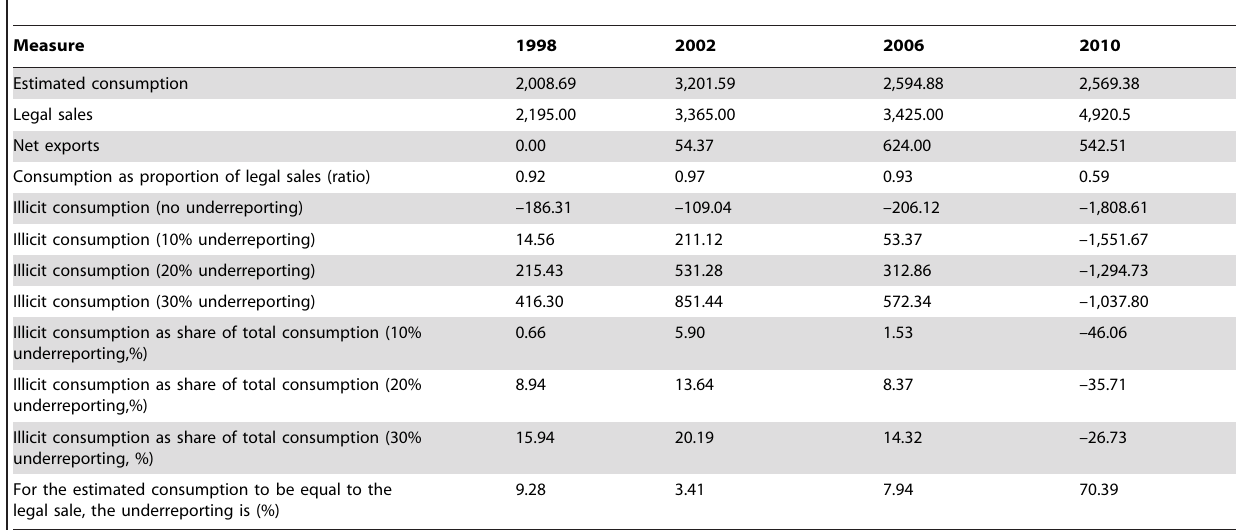
Table 2. Legal Cigarette Sales, Estimated Consumption, and Illicit Consumption, 1998–2010 (millions of packs).